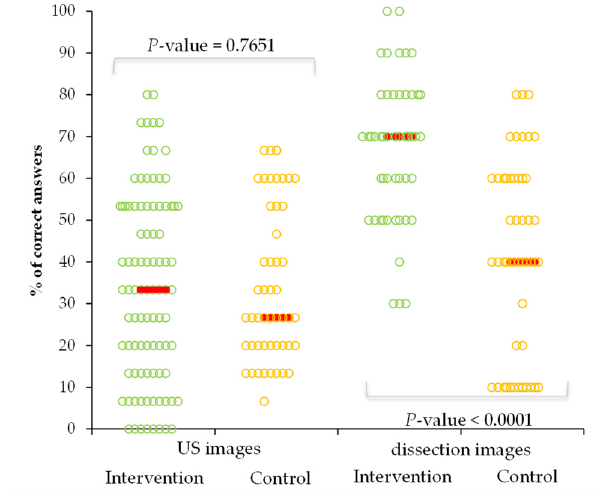
Figure 4. Performances in the correct identification of cardiovascular images by groups. (US = hand- held US images) Horizontal lines are the median values, and the circles are raw data.